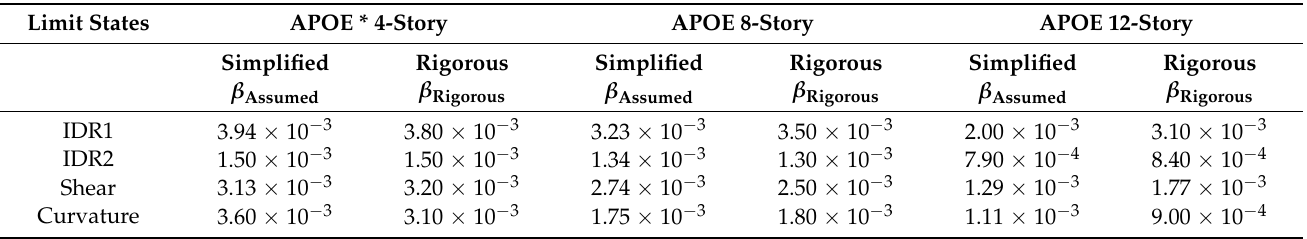
Table 7. Annual probability of exceeding different limit states for the case study buildings obtained through rigorous assessment and via the simplified approach with assumed values of total dispersion. Limit